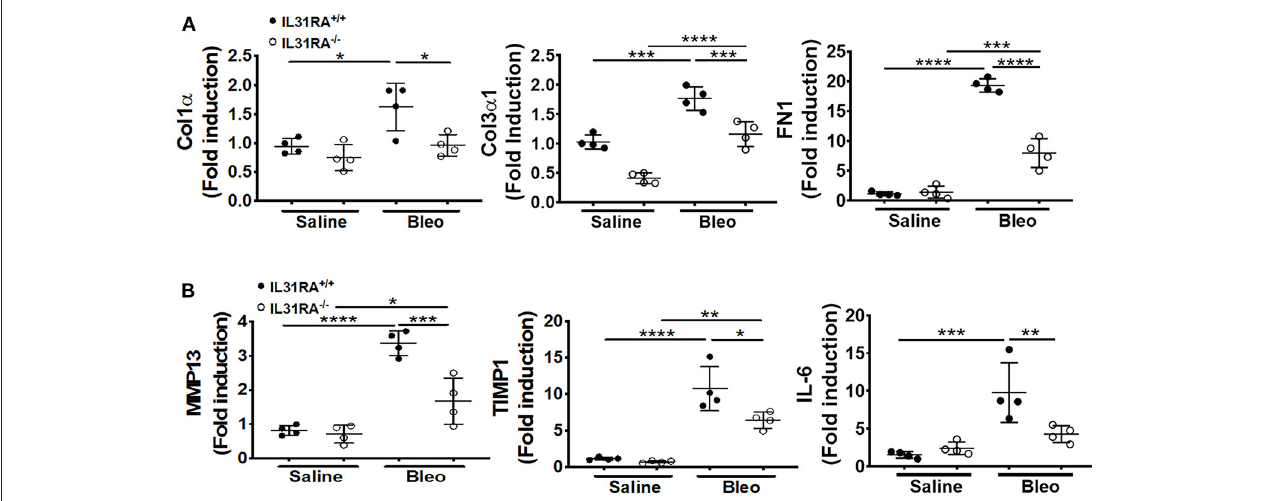
FIGURE 3 | The loss of IL-31RA signaling attenuates the expression of fibrosis-associated genes during bleomycin-induced pulmonary fibrosis. Total lung RNA was isolated from wildtype and IL-31RA − / − mice treated with saline and bleomycin and fibrosis-associated genes quantified using real-time RTPCR. (A) Quantification of ECM gene transcripts including Col1 α , Col3 α 1, and Fn1. (B) Quantification of gene transcripts involved in ECM remodeling and production including Mmp13, Timp1, and IL-6. Data presented as Mean ± SEM ( n = 4/group). Statistical analysis was performed using one-way ANOVA with Tukey’s multiple comparisons test * p < 0.05; ** p < 0.01; *** p < 0.005; **** p < 0.001.